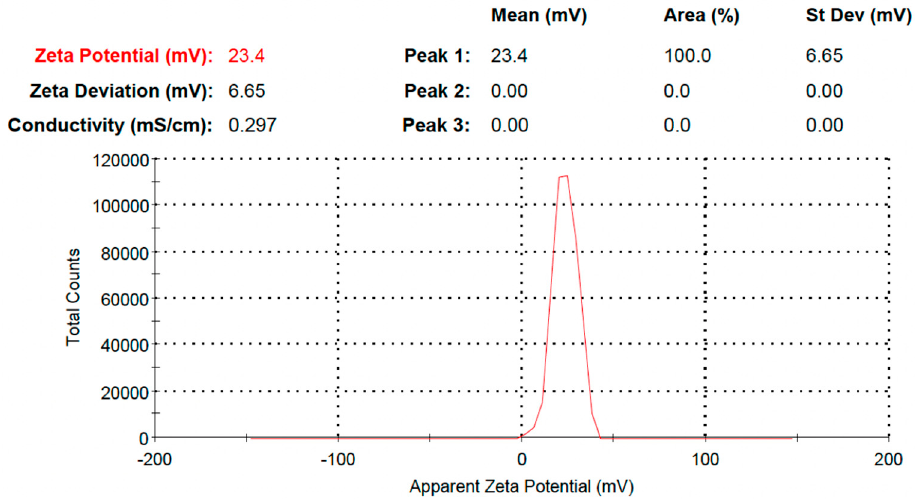
Figure 11. Zeta potential of TAF PEGylated chitosan nanoparticles.